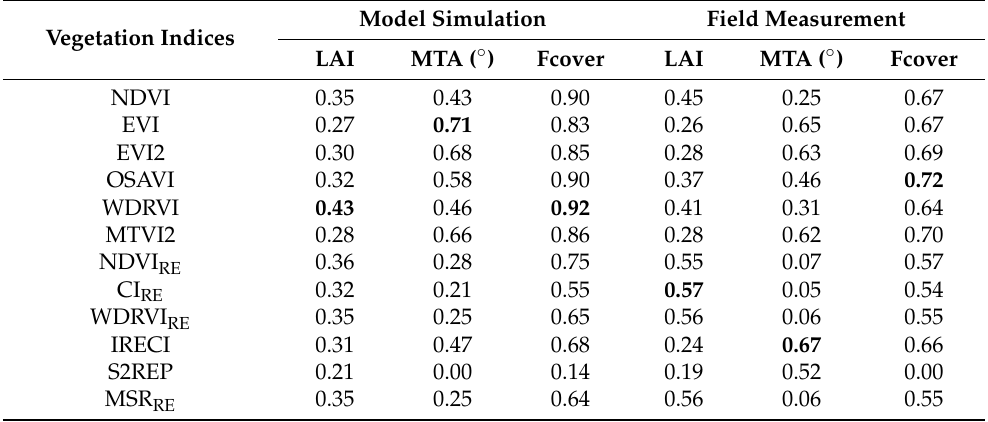
Table 5. The coefficient of determination, R 2 , between three structural parameters and vegetation indices. Vegetation